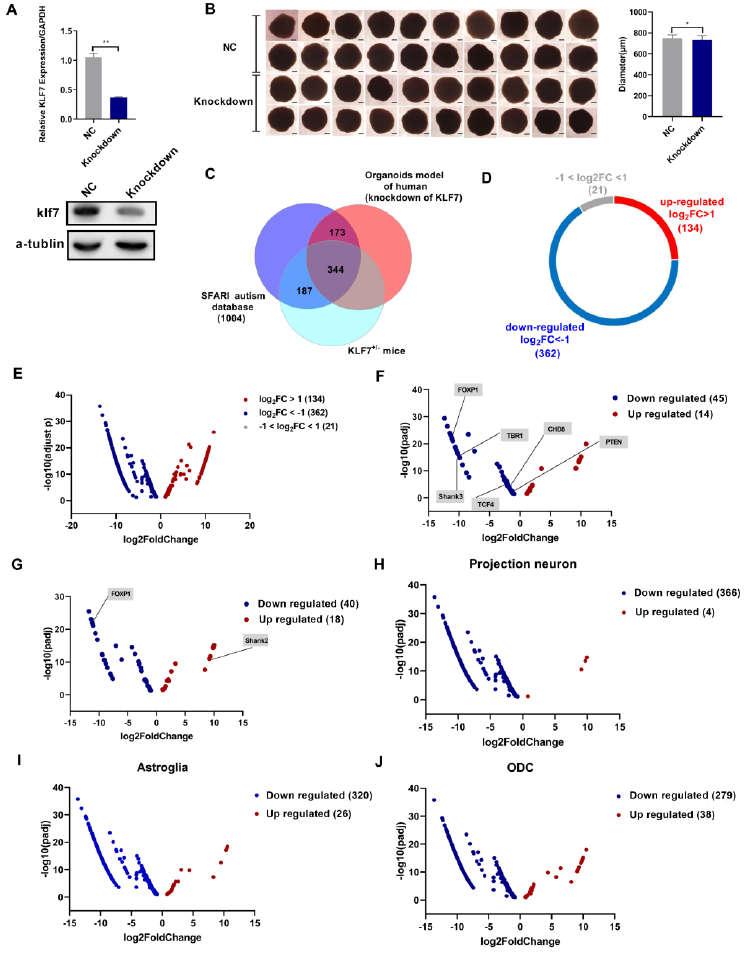
Figure 5. Klf7 knockdown in a human induced pluripotent stem cell (hiPSC)-derived organoid model. ( A ) Klf7 knockdown efficiency measured by qPCR ( n = 3) and Western blot ( n = 3) in organoids (90 days after differentiation). ( B ) The morphology of organoids in the control group and klf7 knockdown group after 90 days of differentiation. Klf7 knockdown significantly decreased the di- ameter of organoids; the average diameter of the control group was 750.8 μm, and the average di- ameter of the klf7 knockdown group was 734.8 μm. n = 20. Scale bar = 500 μm. ( C ) Genes shared between the SFARI autism database, klf7 +/− mice and klf7 knockdown organoids. The total number in each subset is noted in parentheses. ( D , E ) Of the 517 ASD risk genes that were dysregulated after klf7 deletion in hiPSC-derived organoids, 134 showed significantly upregulated expression (log2FC > 1), 362 showed significantly downregulated expression (log2FC < − 1), and 21 showed minimal changes ( − 1 < log2FC < 1). ( F ) ASD risk genes (including 14 that showed upregulated expression and 45 that showed downregulated expression, adjusted p < 0.01) found to be dysregulated in klf7 knockdown organoids and identified as high-confidence genes in the ASD population by exome sequencing are indicated in the volcano plot. Some high-confidence ASD risk genes are shown. ( G ) ASD risk genes (including 18 that showed upregulated expression and 40 that showed downregu- lated expression, adjusted p < 0.01) dysregulated in klf7 knockdown organoids and identified as high-confidence genes by Willsey et al. are indicated in the volcano plot. Some high-confidence ASD